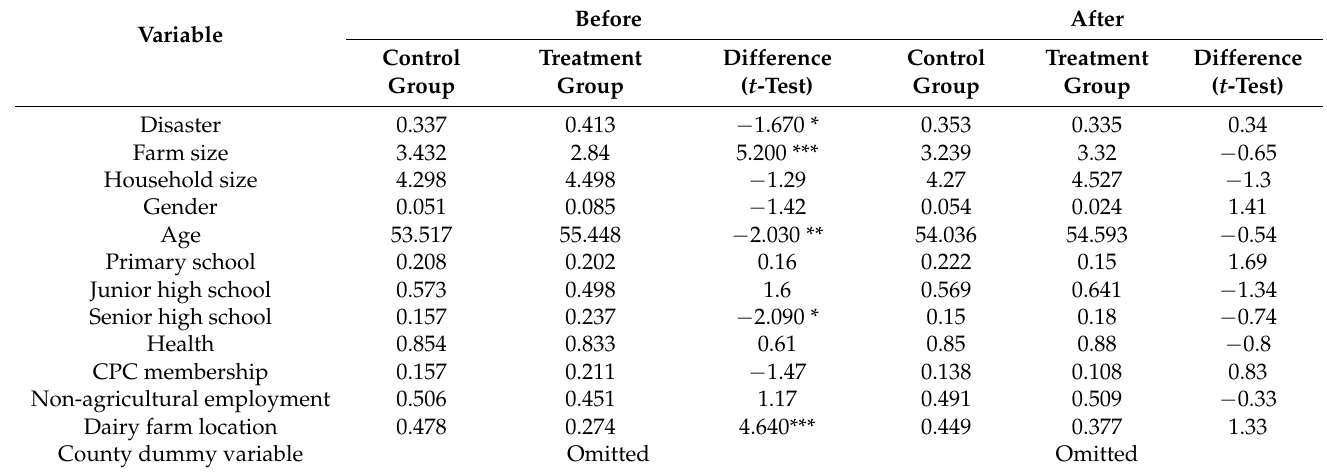
Table A2. The sample mean difference of control variables before and after matching.